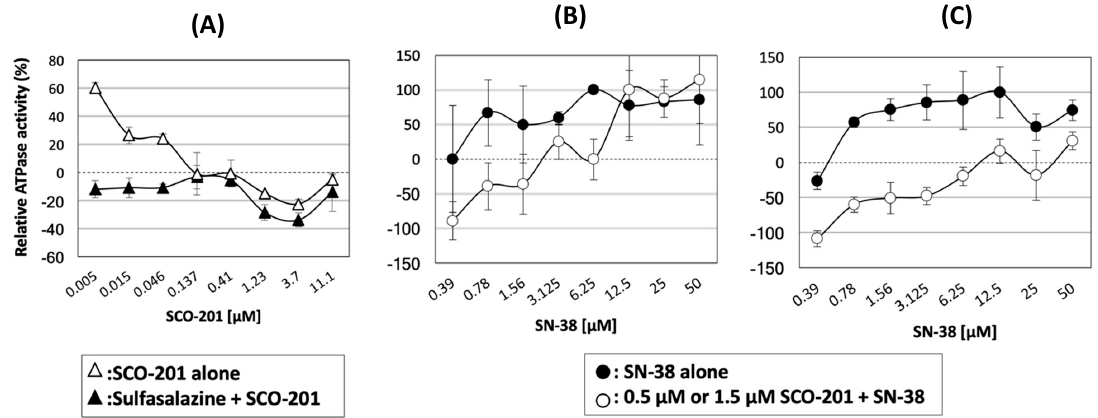
Figure 5. SCO-201 inhibited drug-stimulated ATPase activity of BCRP. (A) The effect of increasing concentrations of SCO-201 on basal and sulfasalazine-stimulated ATPase activity of BCRP. The data are indicated as relative ATPase activity, normalized with respect to basal (untreated) and maximal (sulfasalazine-stimulated) ATPase activity of BCRP. Sulfasalazine alone resulted in a maximal ATPase activity of 104.8 nmol Pi/mg protein/min compared to the baseline activity of 50.68 nmol Pi/mg protein/min. (B, C) The effect of 0.5 µM (B) and 1.5 µM (C) SCO-201 on SN-38-stimulated ATPase activity of BCRP. Error bars on all graphs represent SD determined from duplicates.